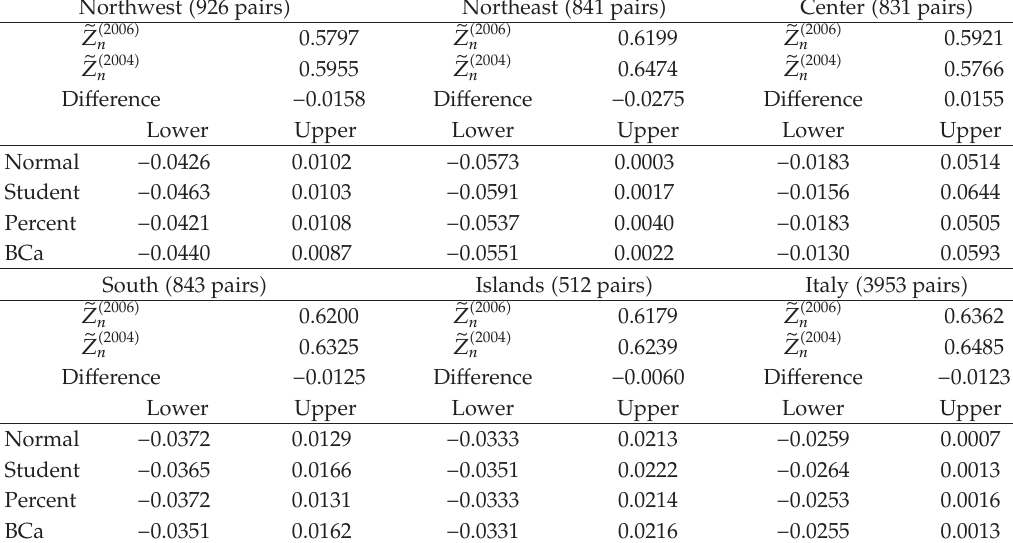
Table 4: 95% confidence intervals for the di ff erence of the Zenga indices between 2006 and 2004 in the Italian income